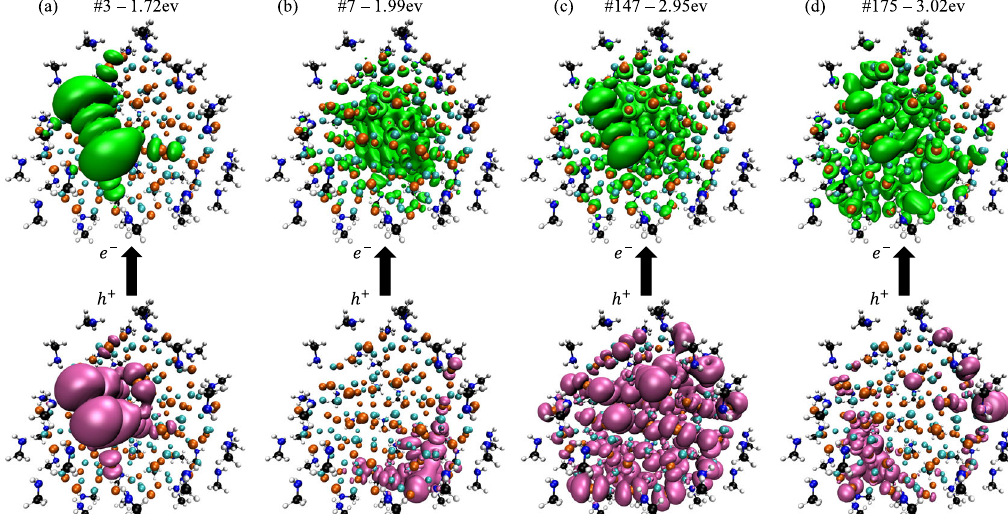
Fig. 2 Representative attach and detach densities for Cd 91 Se 91 . Attach (top-green) and detach (bottom-magenta) densities for four representative excited states of the 2 nm diameter methylamine-passivated Cd 91 Se 91 NC, showing the locations of the electron and hole, respectively. a 3 rd excited state. b 7 th excited state. c 147 th excited state. d 175 th excited state. These correspond to surface-to-surface, surface-to-bulk, bulk-to-bulk, and surface-to-bulk states, respectively. The bright states are delocalized in a similar way to the 147 th excitation, in the way that would be expected from the particle-in-a- sphere model. The colors of the atoms in the NC are: Cd-cyan, Se-orange, C-black, N-blue, H-white.